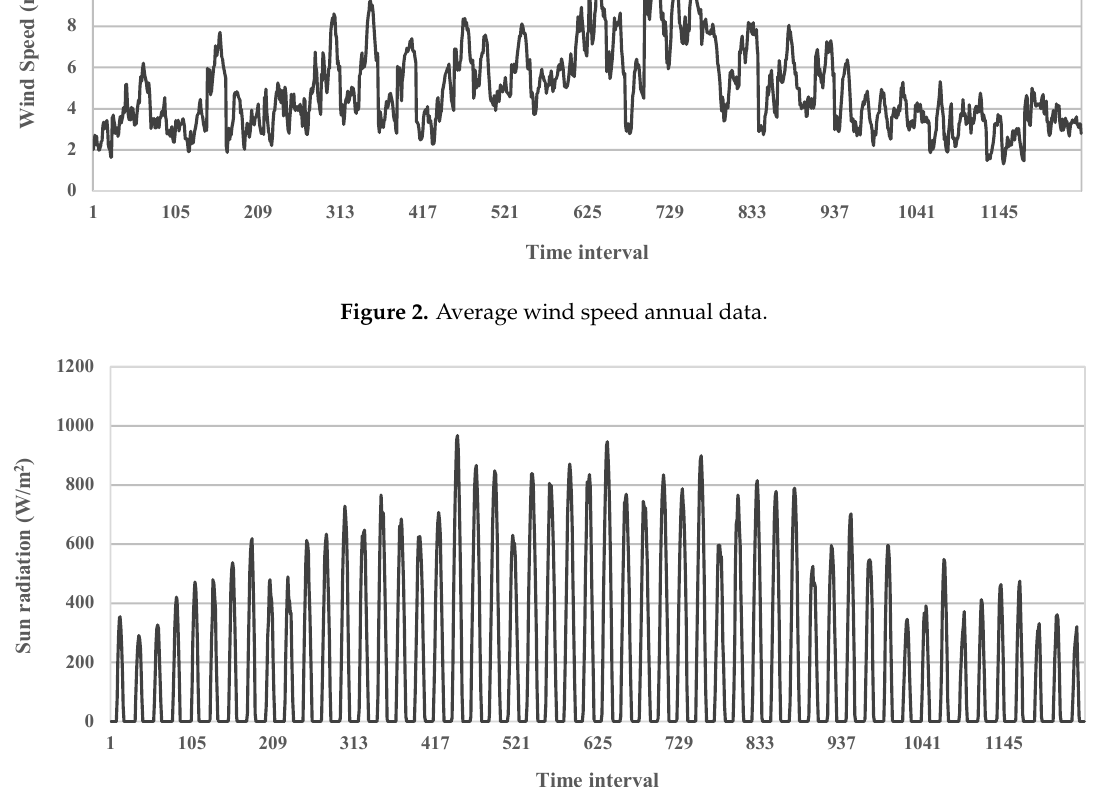
Figure 3. Average sun radiation annual data.